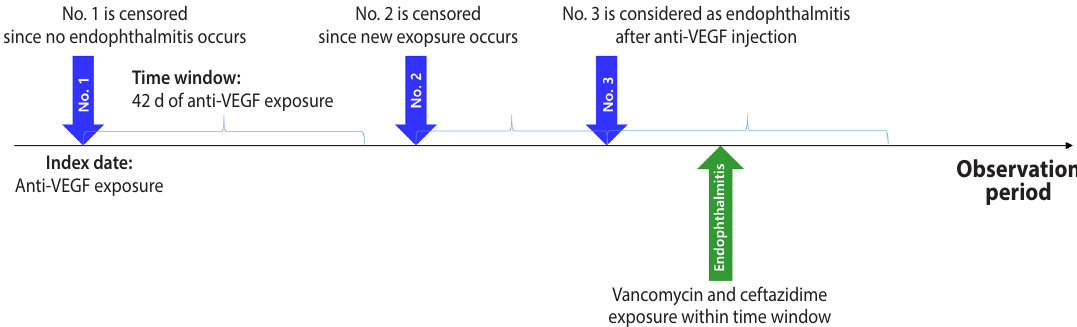
Figure 1. The definition of endophthalmitis occurrence among patients receiving intravitreal anti-vascular endothelial growth factor (VEGF)